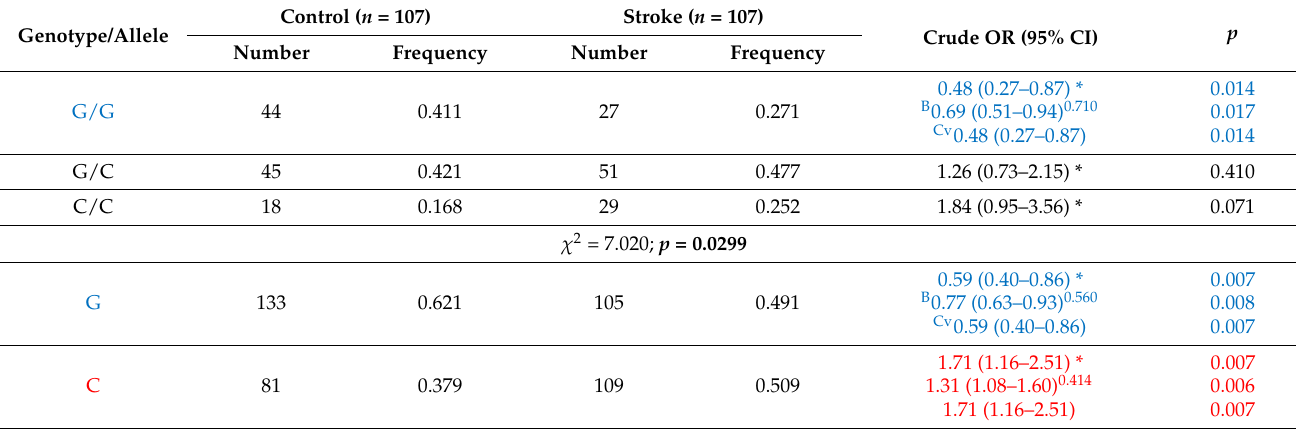
Table 7. Distribution of genotypes and alleles of the c.-227G > C (rs10459953) polymorphism in the NOS2 gene and odds ratios (ORs) with 95% confidence intervals (95% CIs) in patients with stroke and